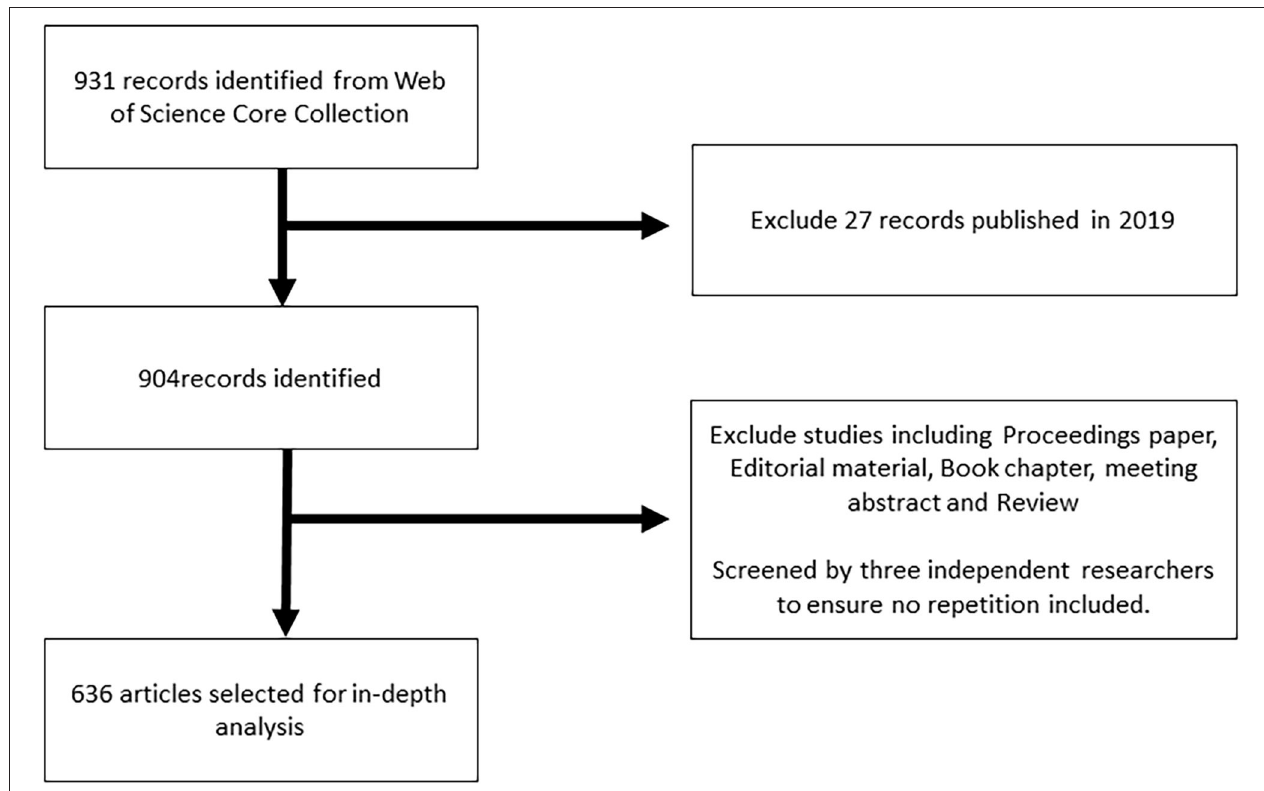
FIGURE 1 | The flowchart of the methodology.